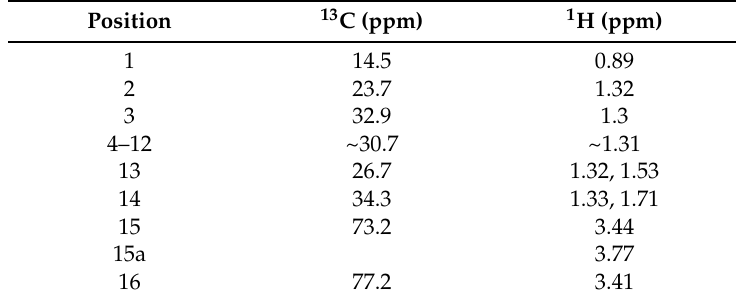
Scheme 2. NMR hexacosanoylceramide carbon atom numbering scheme. Table 1. Carbon and proton chemical shifts for hexacosanoylceramide in THF- d 8 1 . Position